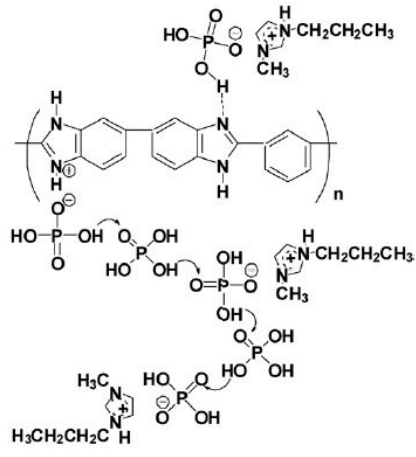
Figure 20. Schematic of the structure of proton transport mechanism in the H 3 PO 4 /PMIH 2 PO 4 /PBI membrane under anhydrous condition [240]. Copyright 2008, reproduced with permission from Elsevier